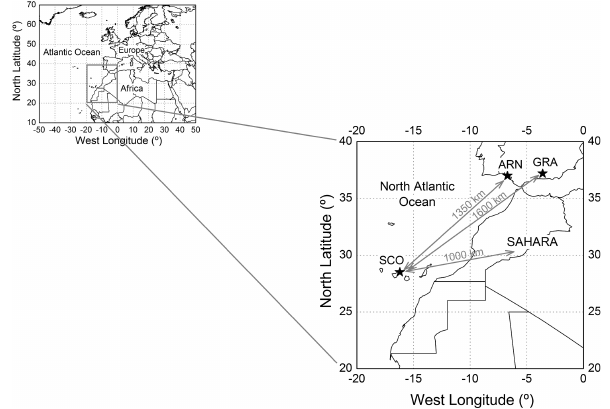
Fig. 1. Map showing the geographical situation of the three stations, Santa Cruz de Tenerife (SCO), “El Arenosillo” (ARN) and Granada (GRA) respect to Saharan dust